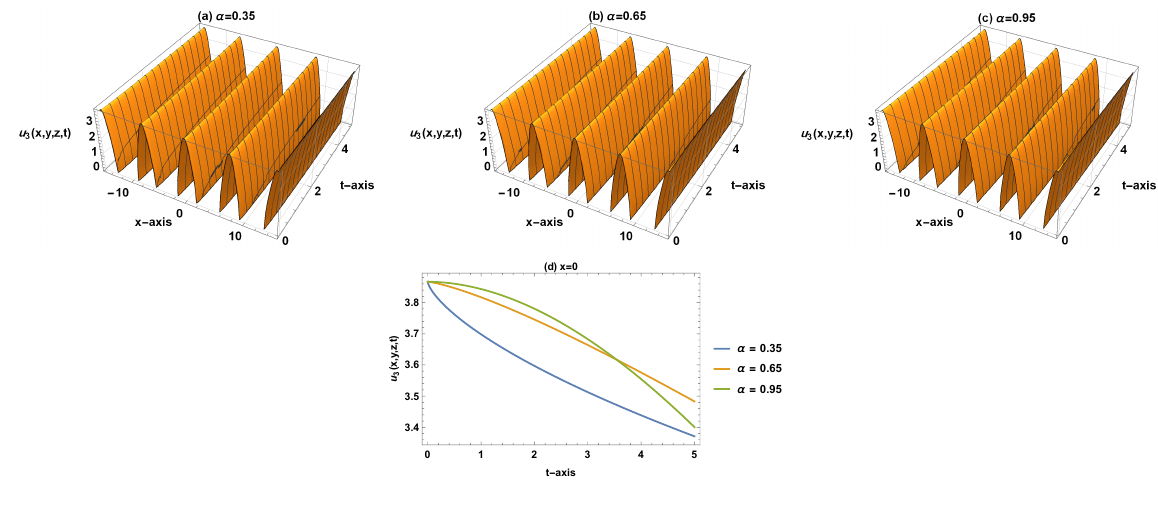
Fig. 3: (a)-(d) The wave solution u 3 ( x , y , z , t ) given by (24) in 3D-and 2D-plots when y = z = 0 .